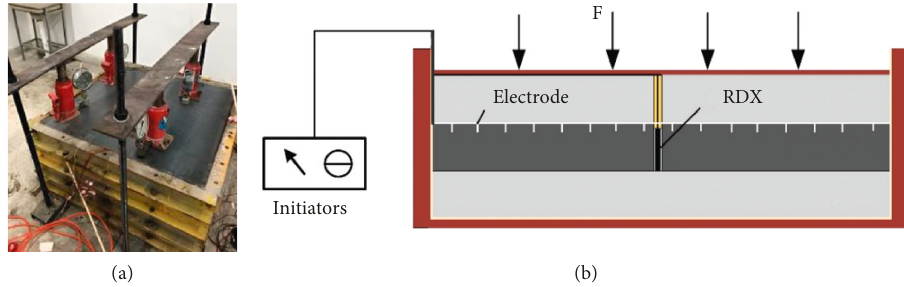
Figure 1: The experimental system. (a) Prepared model. (b) Experimental model diagram.